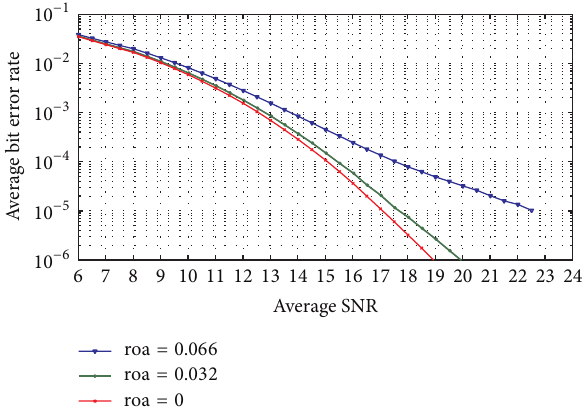
Figure 10: The average probability of bit error of code-time diversity system in Rayleigh frequency selective fading channel with 𝑁 = 4 and 𝐿 = 2 , using orthogonal and nonorthogonal spreading codes.